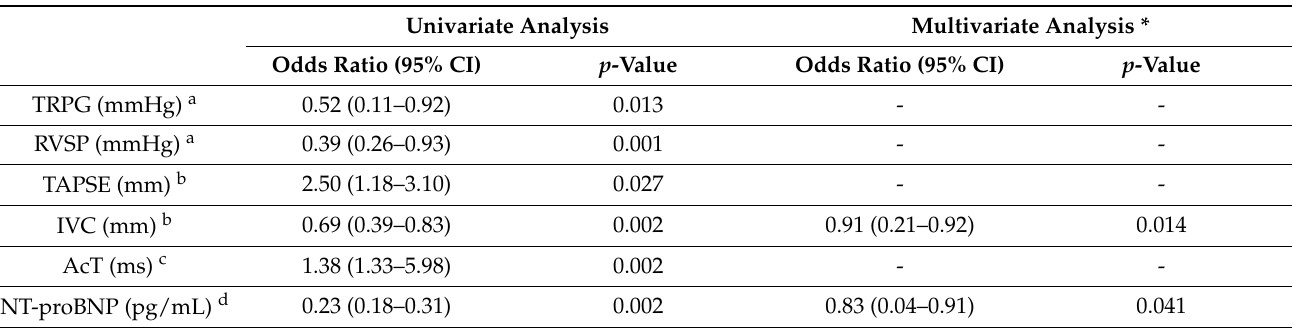
Abbreviations—see Table 1. * results of multivariate analysis shown only for statistically significant parameters. a Odds ratio and 95% CI corrected for an increase of 10 mmHg. b Odds ratio and 95% CI corrected for an increase of 1 mm. c Odds ratio and 95% CI corrected for an increase of 10 ms. d Odds ratio and 95% CI corrected for an increase of 100